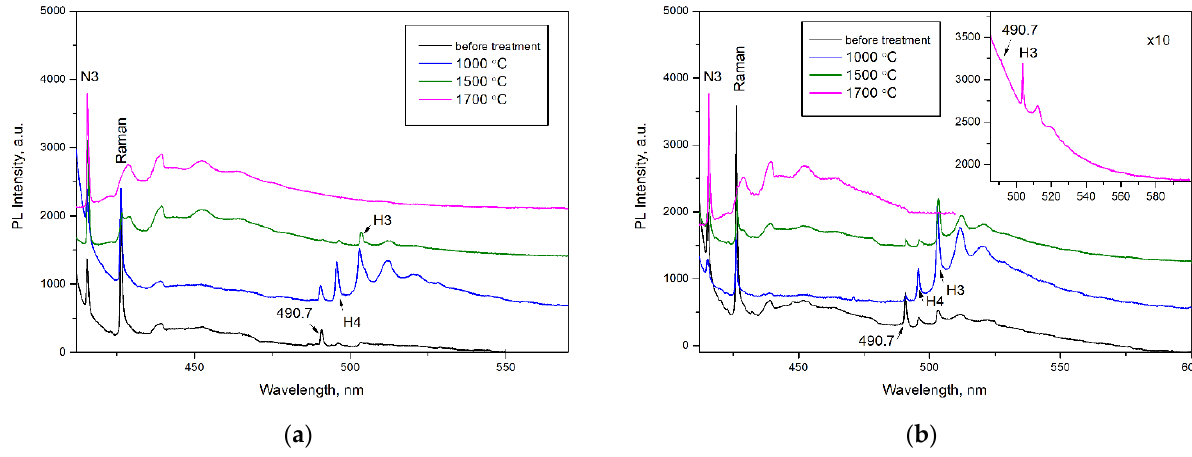
Figure 6. PL spectra (λ ex = 405 nm) of the ( a ) AO1666 and ( b ) AO1894 diamonds. Inset in ( b ) shows the weak 490.7 nm and H3 (503.2 nm) systems in the PL spectrum of the AO1894 diamond annealed at 1700 °C. Treatment at 600 °C produces no changes in the PL spectra when excited at λ ex = 405 nm. The spectra were shifted for clarity.